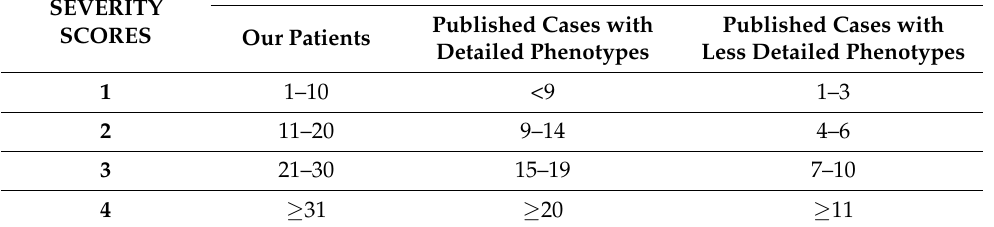
Table 2. Established disease severity scores based on the cumulative clinical scores in the three different patient